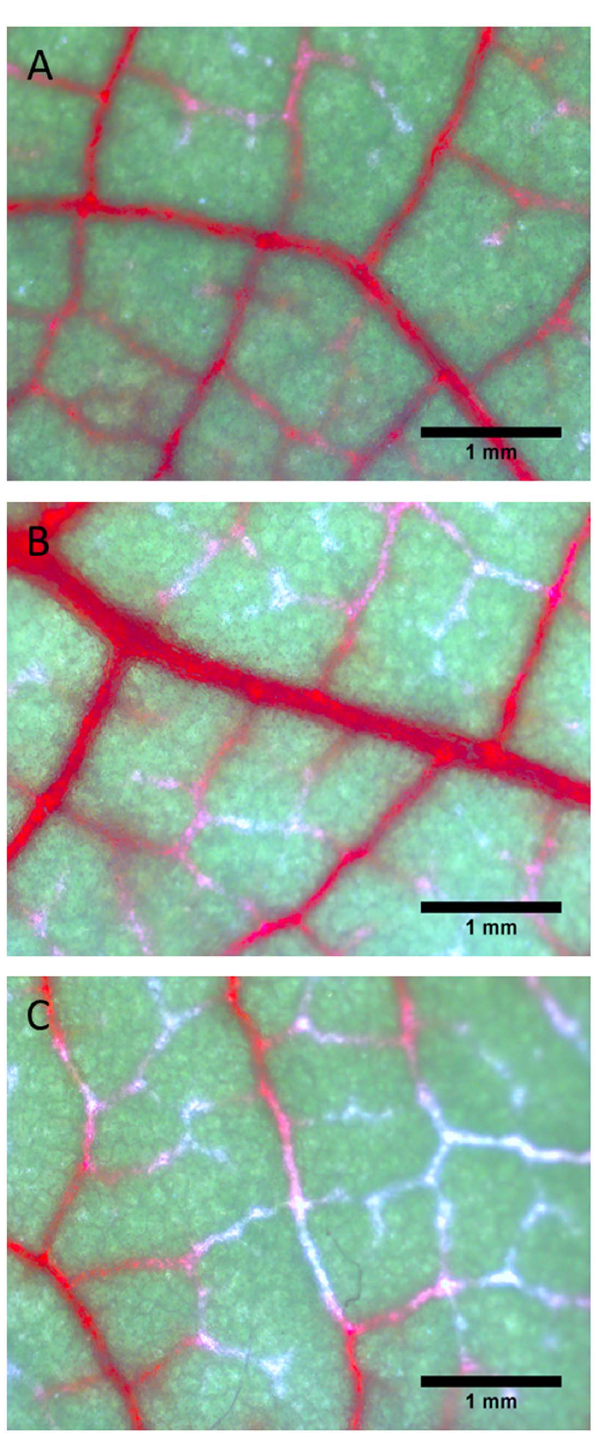
Figure 4. Typical images of transpiring P.trichocarpa leaves that were allowed to take up safranin solution. (A) A control leaf was excised from a well-watered plant, and the petiole was immersed for 2 h in safranin solution. Transpiration during dye uptake was promoted by placing the leaf near a fan at , 1,000 m mol m 2 2 s 2 1 photosynthetic active radiation. Most leaf veins were stained indicating minimal xylem embolism. (B) Dye uptake in a bench-dried leaf that was subsequently perfused with safranin solution for 2 h. Minor veins exhibited incomplete staining indicating the presence of embolized xylem conduits in minor veins. (C) Dye uptake of a bench-dried